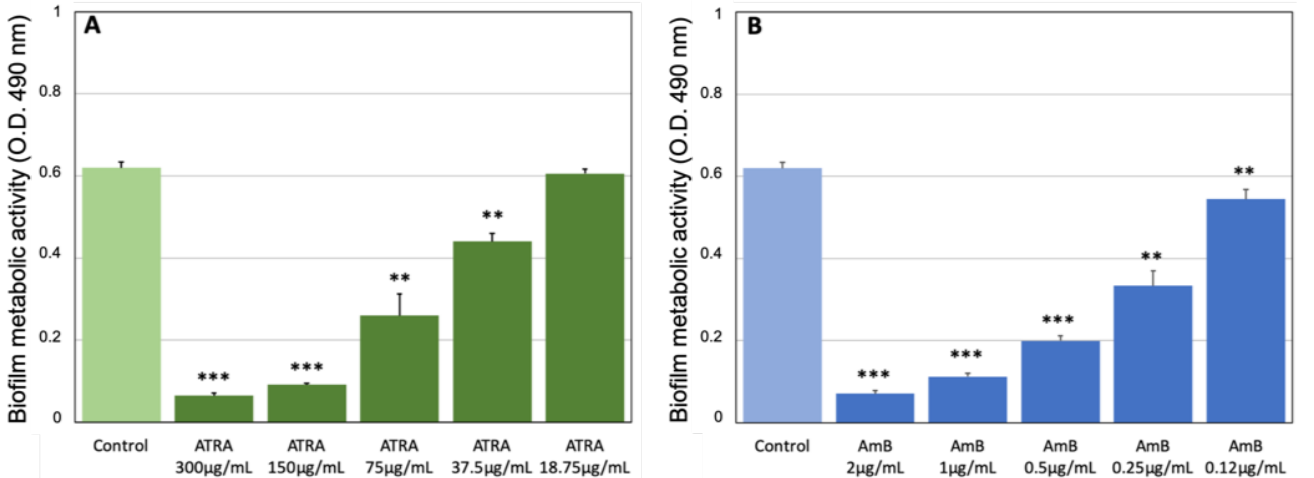
Figure 2. Effect of ATRA on metabolic activity of C. albicans biofilm. ( A ) Candida cultures were incubated for 24 h in the absence or presence of ATRA at various concentrations (300–18.75 µ g/mL). ( B ) AmB (2–0.12 µ g/mL) was used as positive control. Biofilm metabolic activity was analyzed by XTT assay, using a spectrophotometer plate reader at 490 nm. Results are the means ± SD of three independent experiments carried out in triplicate. ** p < 0.01; *** p < 0.001.